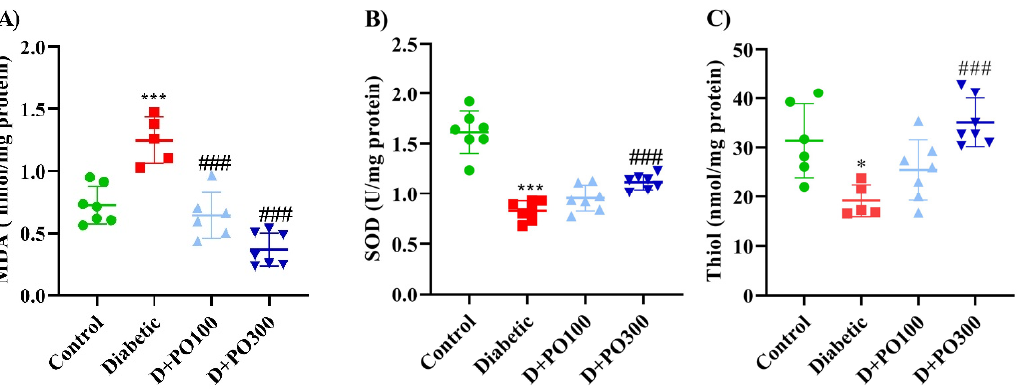
Figure 11. The effects of PO extract on ( A ) MDA, ( B ) SOD, and ( C ) thiol levels in diabetic rats. The